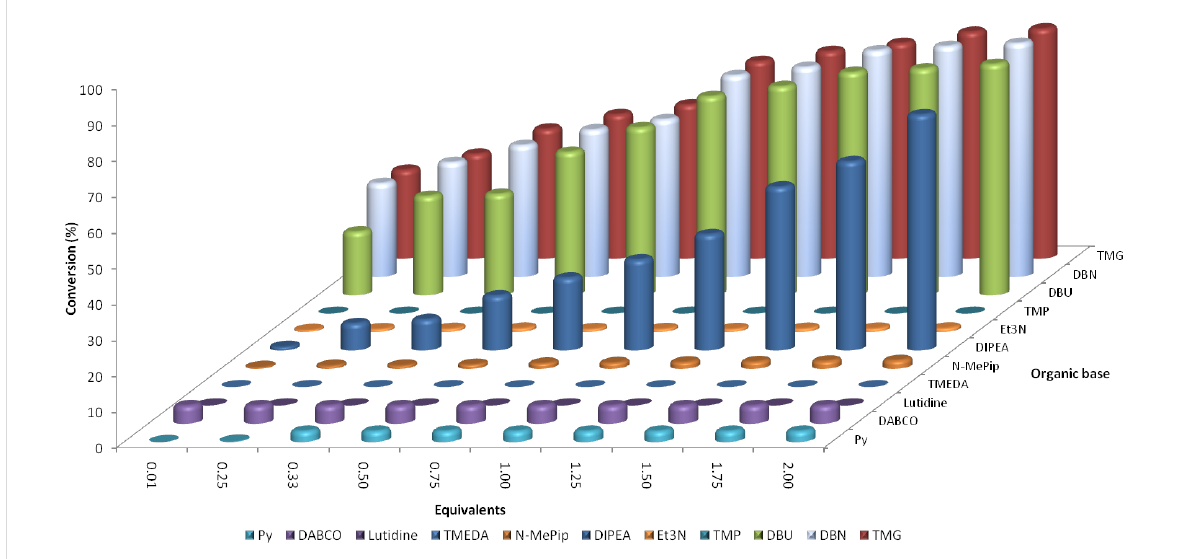
Figure 7: Summary of the results obtained for the organic base screen towards the S N Ar reaction between DCNB ( 4 ) and 4-methoxyphenol ( 5 ) (resi- dence time = 30 s; reactor temperature = 195 °C).